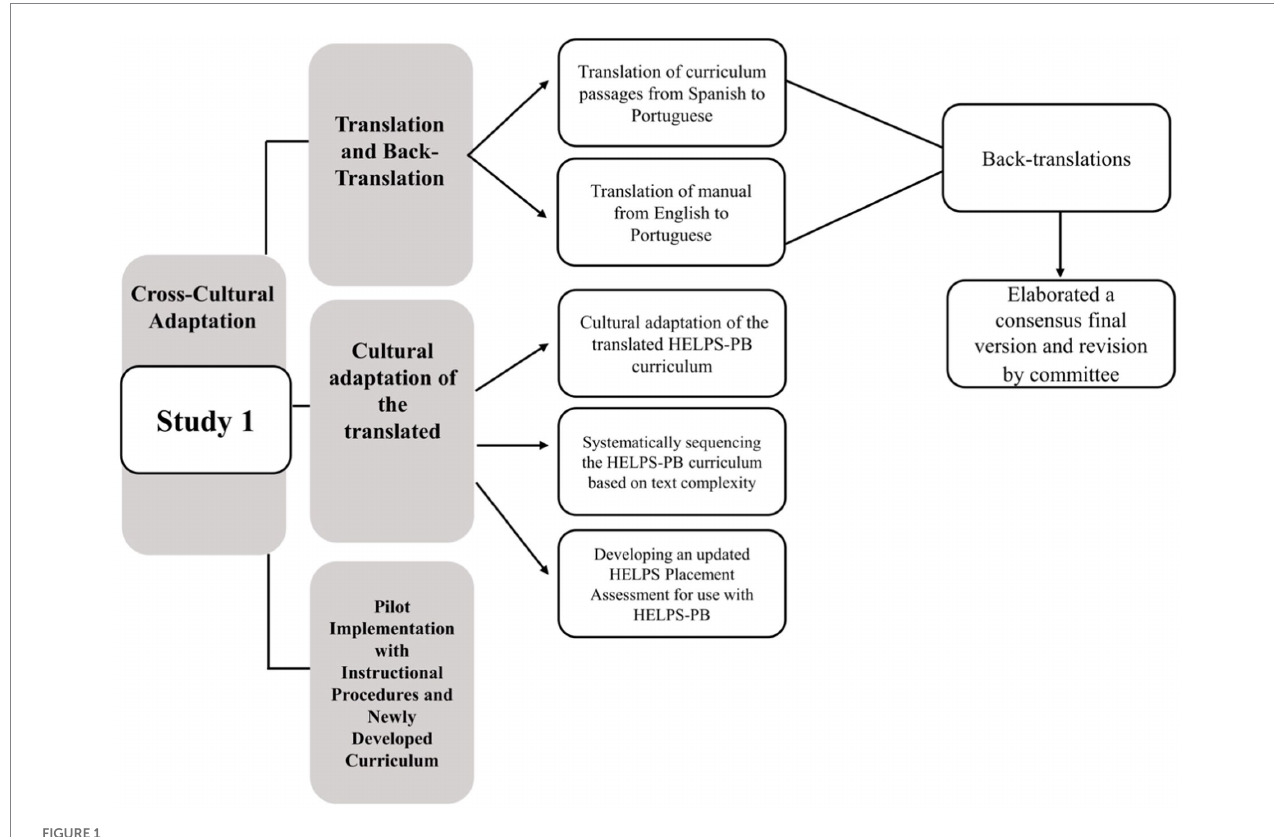
FIGURE 1 Diagram for the primary stages and activities of Study